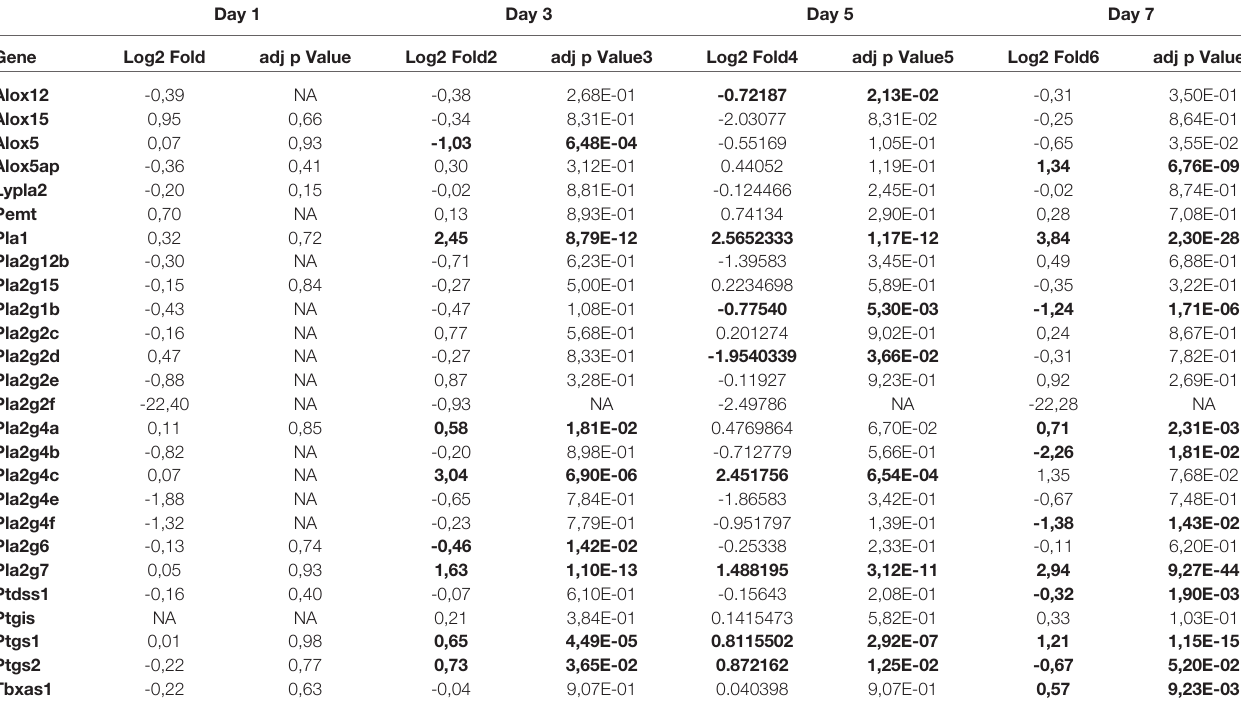
NA, Not Applicable. Statistically signi fi cant values are in